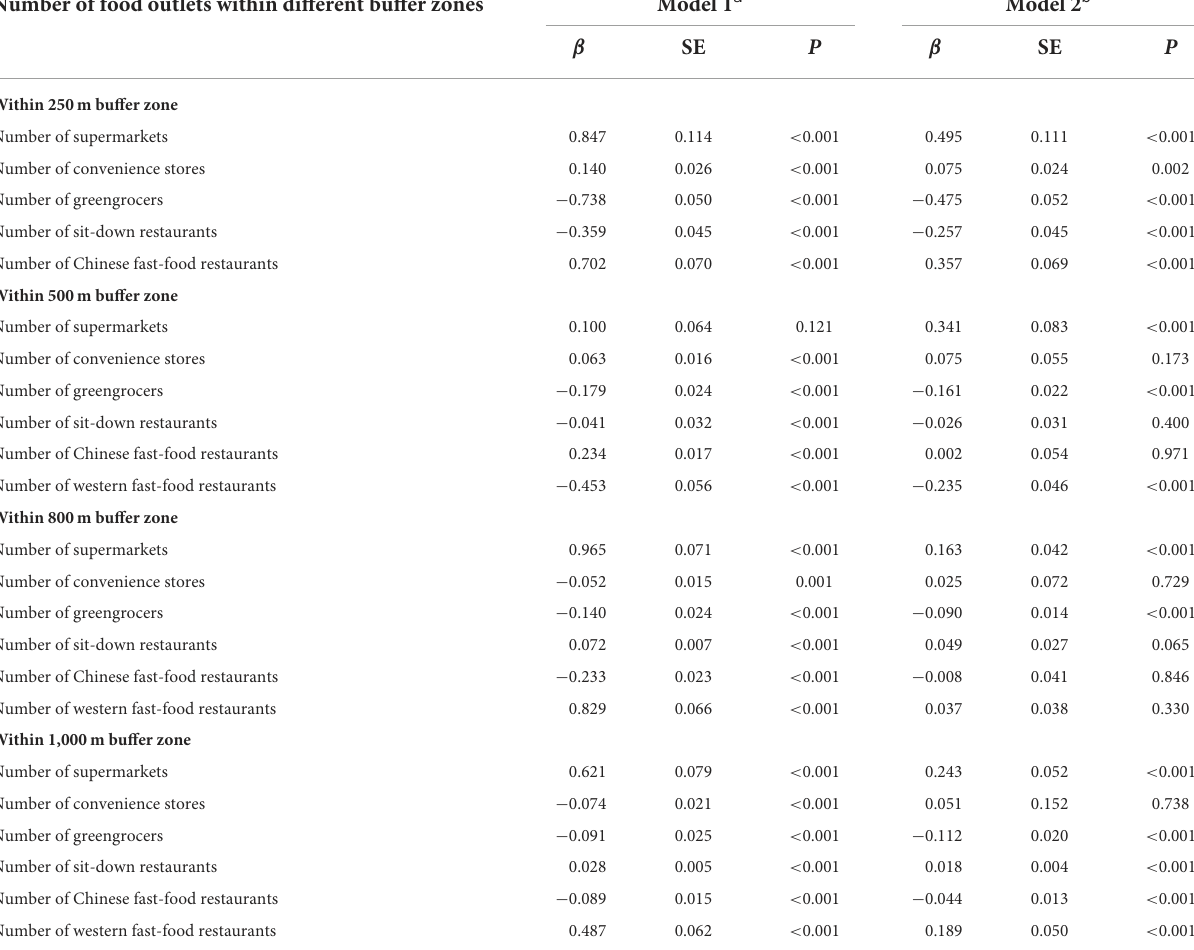
TABLE 5 Associations between the density of food outlets and DDS. Number of food outlets within different buffer zones Model 1